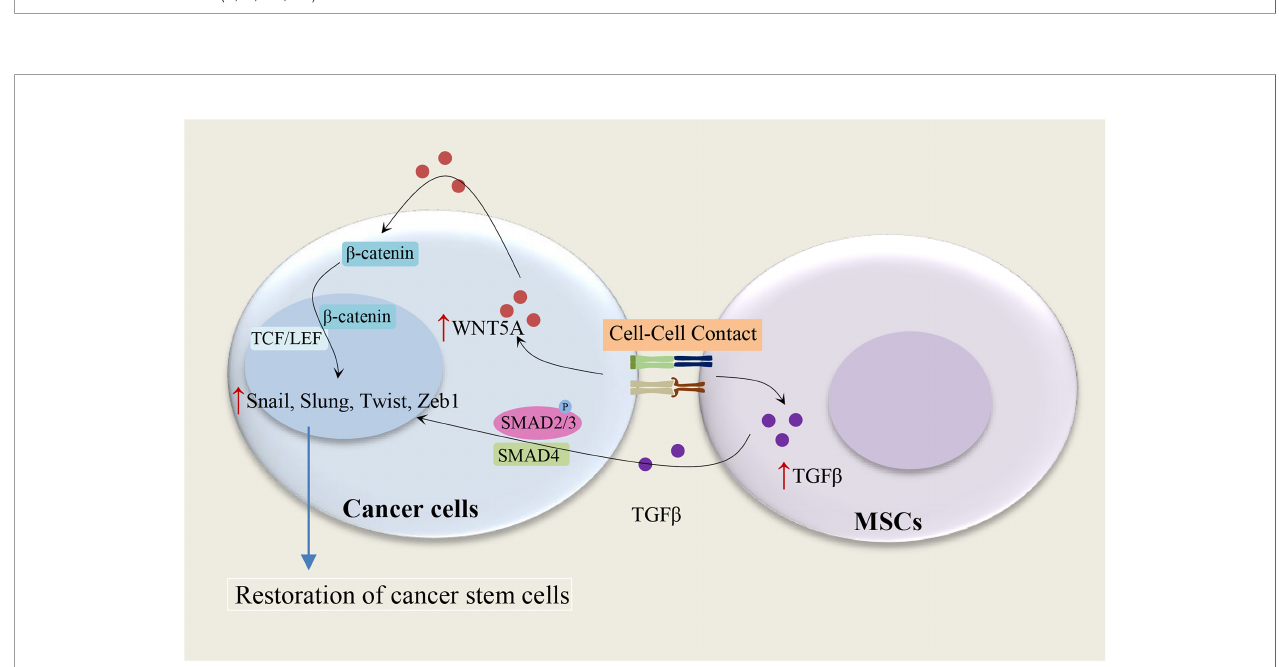
FIGURE 2 | Cell-cell contact and restoration of CSC populations. Cell contact between MSCs and cancer cells leads to an increase of TGF- b 1 in MSCs and WNT5A in cancer cells, subsequently, the paracrine effect of TGF- b 1 and autocrine effects of WNT5A on cancer cells result in the restoration of CSC populations. WNT5A and TGF- b enhance the expression of the Snail-family transcription factors, including Slug , Snail , Twist1 , and Twist2 (15 –